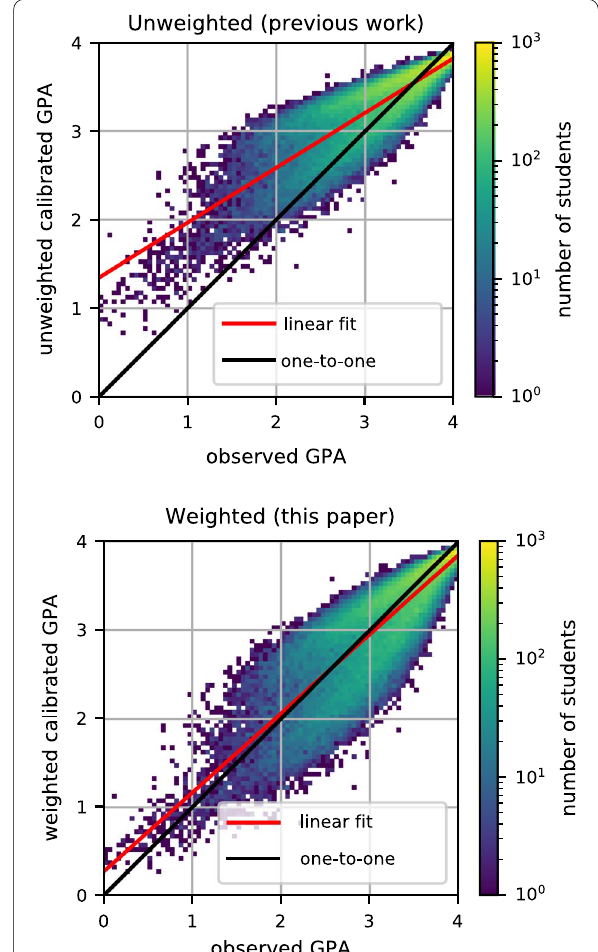
Fig. 2 Observed GPA plotted against unweighted calibrated GPA (left panel, Equation (6) and weighted calibrated GPA (right panel, Equation (7)) for each student. The right panel shows that using the weighted calibrated GPA almost completely eliminates the overestimation that is visible in the left panel for the original unweighted calibrated